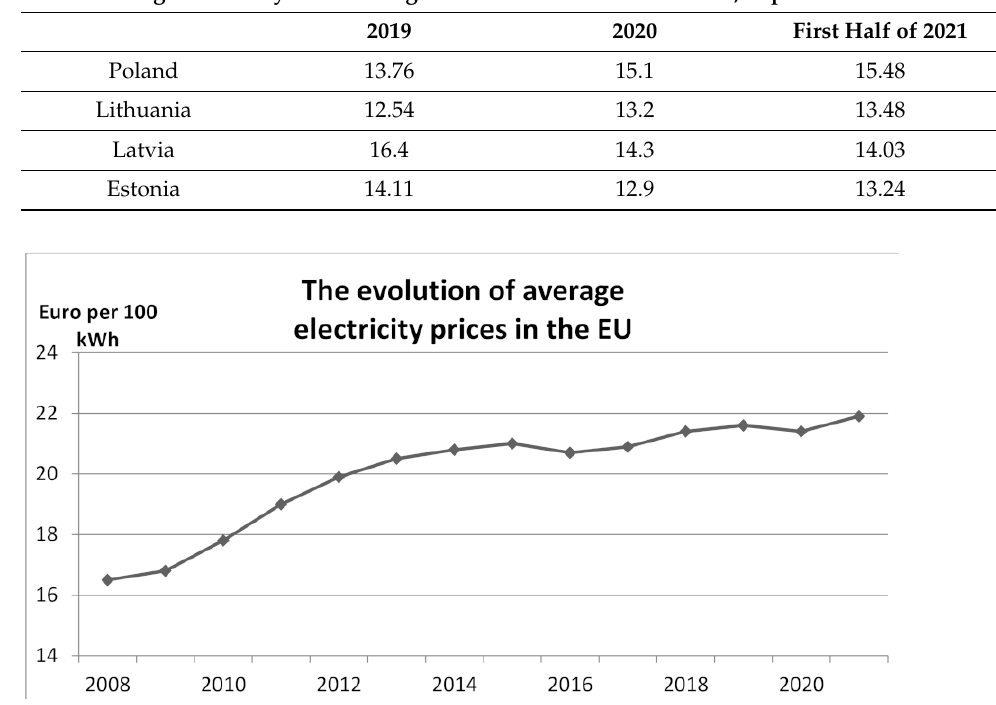
Figure 2. The evolution of average electricity prices per 100 KWh between 2019 and 2021 in the European Union